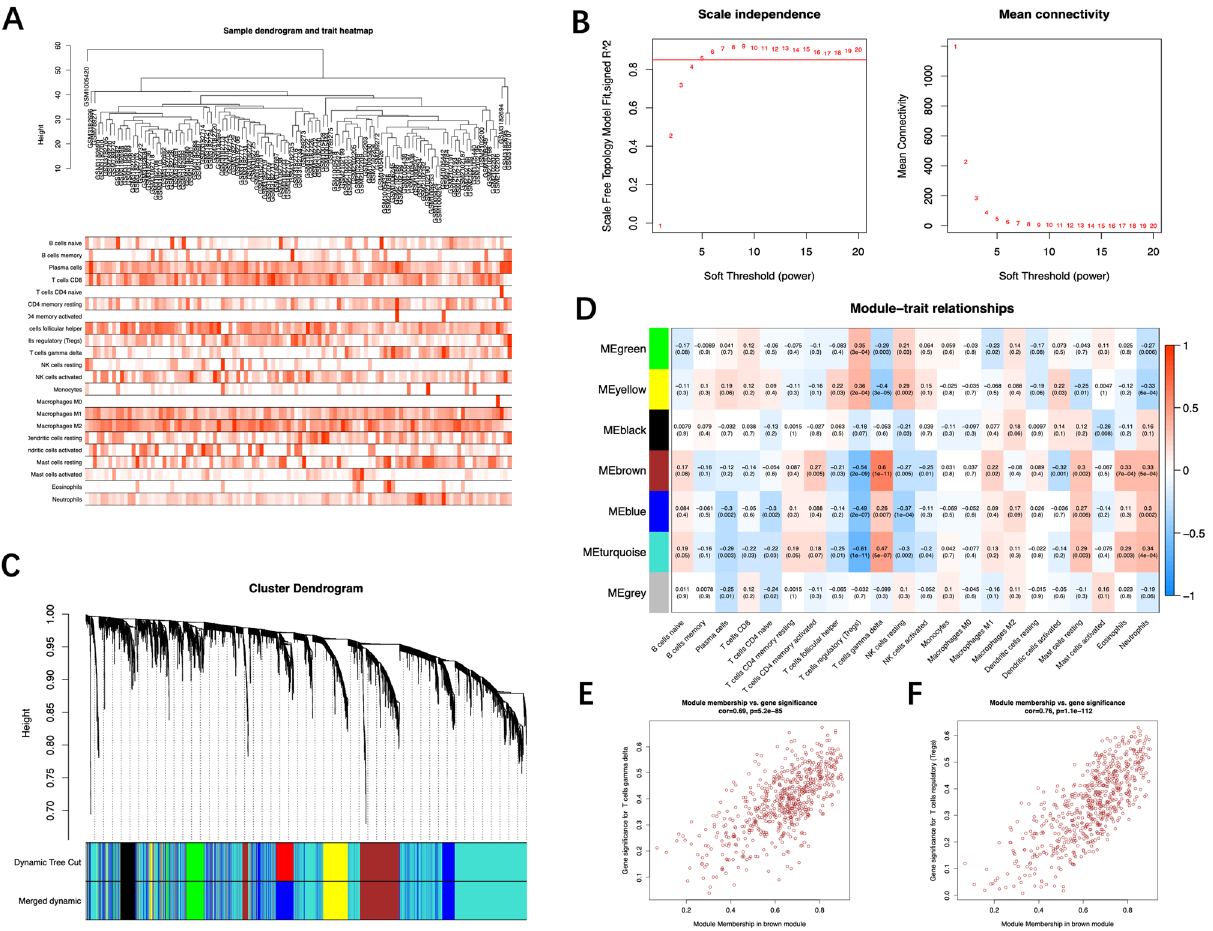
Figure 5. Construction of the weighted coexpression network and identification of key modules (‘WGCNA’ package). ( A ) Sample dendrogram and trait heatmap. ( B ) The selection of the soft-thresholding power β. The red line was set at 0.85, and the soft-thresholding power β was 5. ( C ) Dendrogram of all the differentially expressed genes. ( D ) Module-trait relationships in the constructed network. According to the logistics